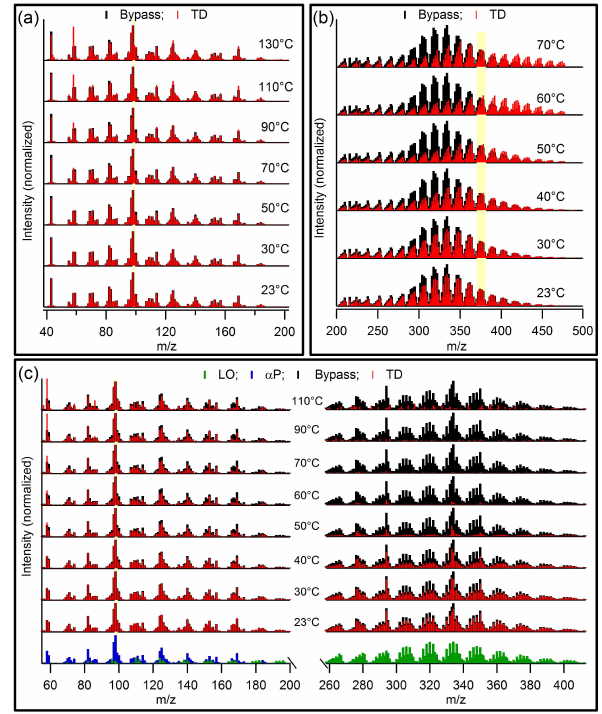
Fig. 3. VUV mass spectra of thermodenuded OA are shown as a function of the thermodenuder temperature (red). The spectra of the particles through the bypass line are shown for reference (black). (a) Spectra for α P particles, normalized to the peak at m/z =98. (b) Spectra for LO particles, normalized to the range m/z =370– 380. (c) Spectra for mixed LO+ α P particles, normalized to the peak at m/z =98. For reference, spectra for α P aerosol (blue) and LO aerosol (green) are shown individually. Note the break in the x- axis and also that the spectral intensity in the right graph ( m/z =260– 415) has been multiplied by a factor of 4 relative to the left graph ( m/z